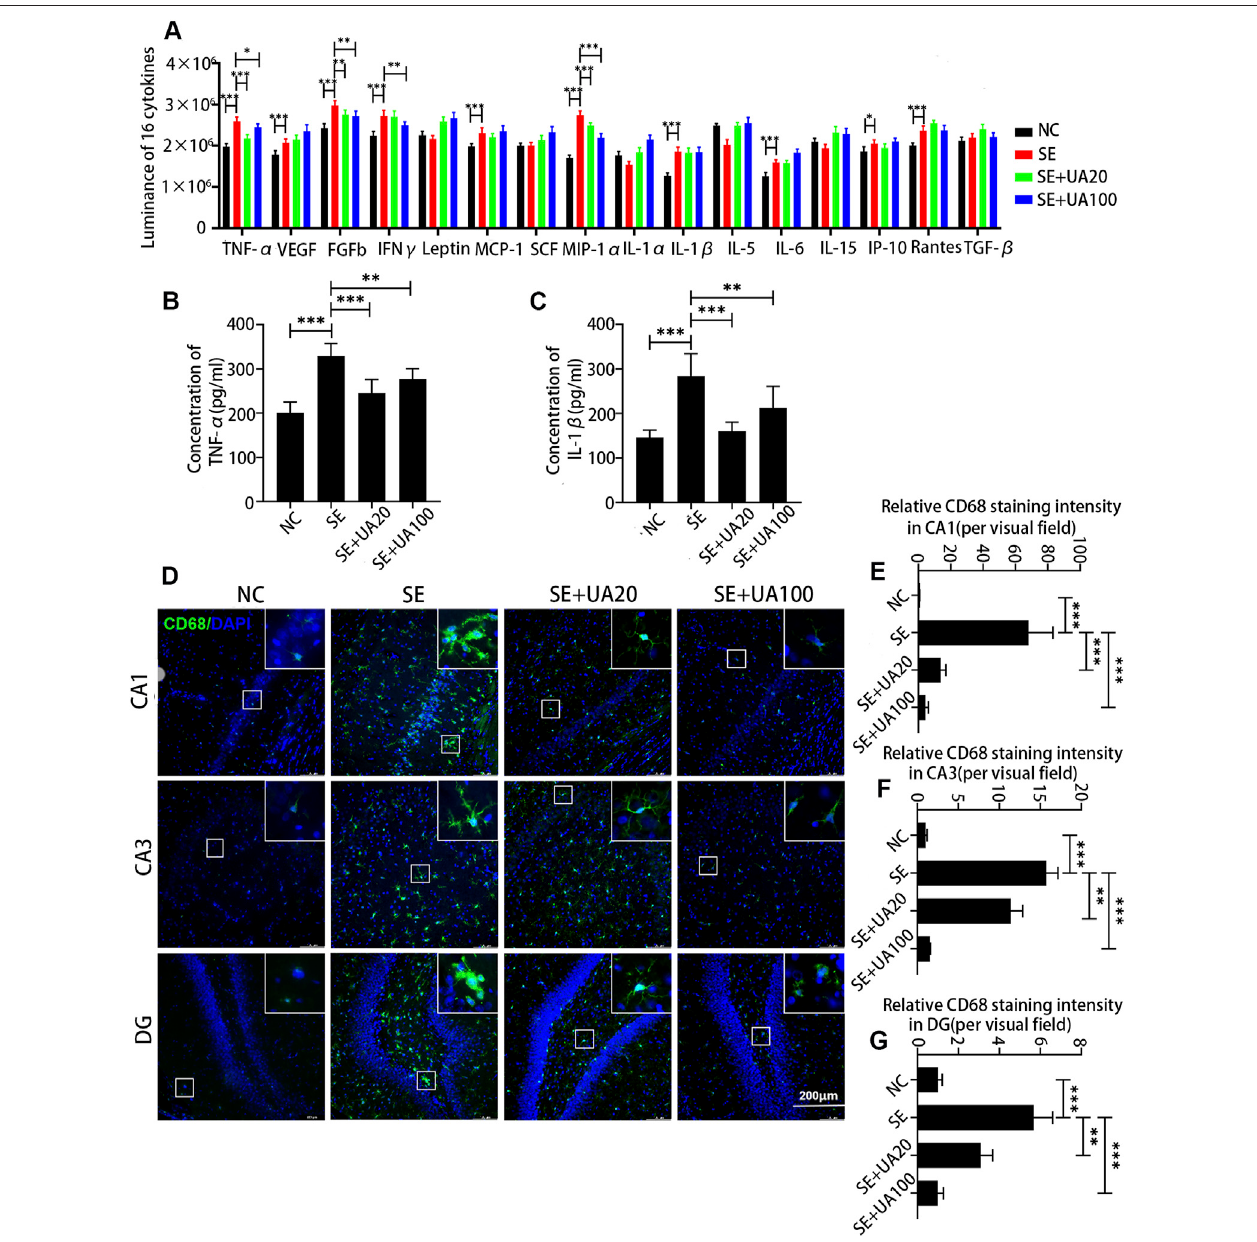
FIGURE6| UAattenuatedneuroin fl ammationinducedbySEinthehippocampus. (A) Theluminanceof16in fl ammatorycytokines, n =6.TheexpressionsofTNF- α (B) and IL-1 β (C) at differentdoses orvehicles, n =6. (D) Immuno fl uorescence stainingofactivated microglia intheCA1, CA3,and DGregions ofthehippocampus. Cell nuclei were stained by DAPI (blue). The activated microglia marked by CD68 were visualized with Alexa Fluor ® 488 secondary antibodies (green). (E – G) Diagrams showed the relative staining intensity of CD68 in the CA1, CA3, and DG areas ofthe hippocampus, three rats per group. ( ppp p < 0.001, pp p < 0.01 vs. SE, all values are expressed as means ±SD, one-way